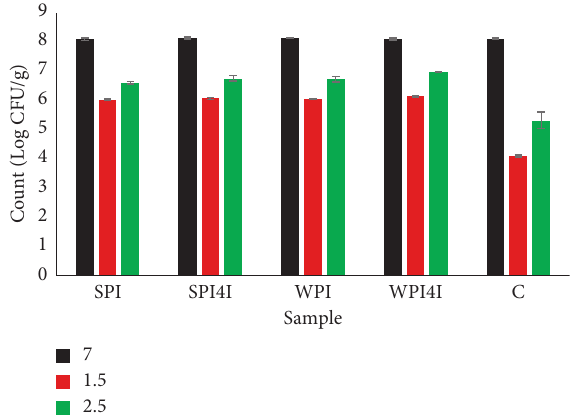
Figure 3: Effect of pH (7, 1.5, 2.5) on the viability of L. reuteri encapsulated within different wall materials; SPI (soy protein isolate 20%), SPI4I (soy protein isolate 20% +inulin 4%), WPI (whey protein isolate 20%), WPI4I (whey protein isolate 20% +inulin 4%), and C (free